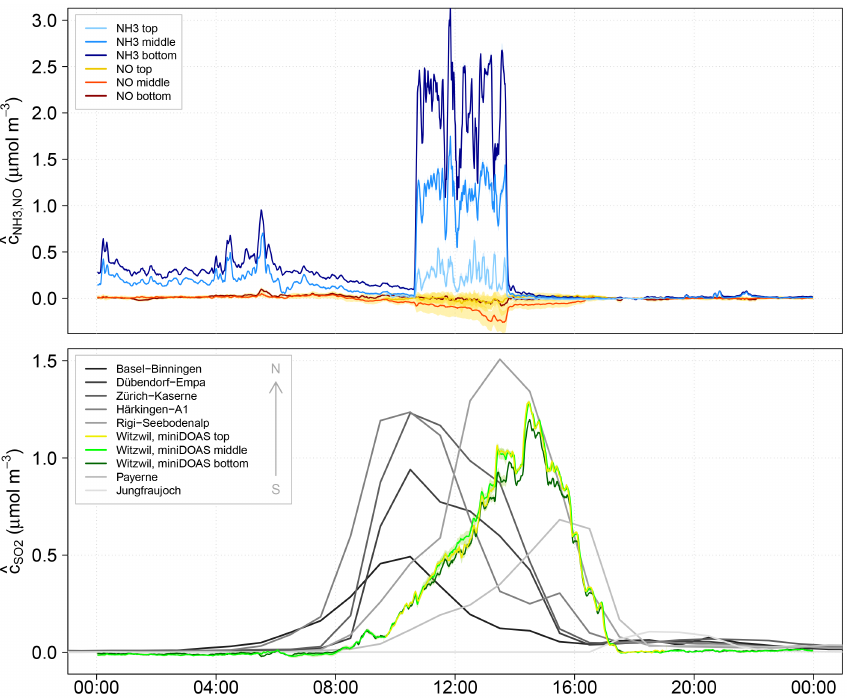
Figure 9. Episode of concentrations ˆ c NH , ˆ c NO and ˆ c SO during the NH 3 gas release experiment (E2, Table 1) coinciding with a SO 2 peak 3 2 due to the passage of the plume from the Icelandic Bár¯darbunga volcano (Boichu et al., 2016; Gauthier et al., 2015; Umweltbundesamt, 2014); miniDOAS concentrations ˆ c i (coloured) are shown as 5min running mean ± SE i (data gaps from the topmost miniDOAS instrument result from low light due to software crashes); in grey, concentrations are shown from the Swiss Air Quality Monitoring Network (www.